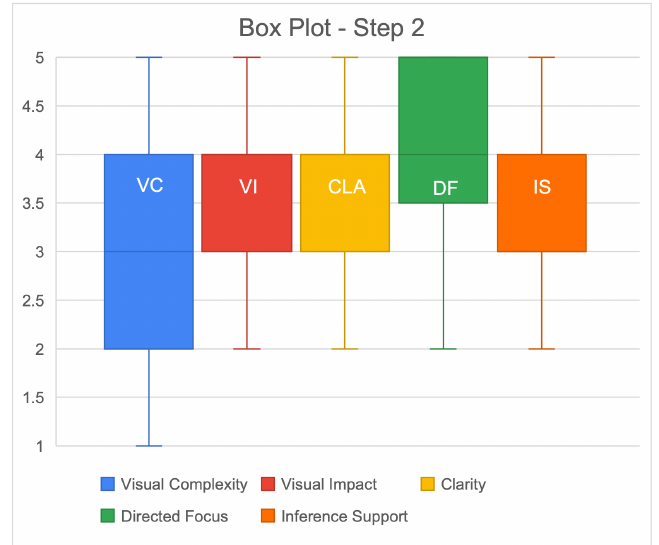
Figure 6. Boxplot chart for the results associated with the visual characteristics of Step 2 instructions— remove the screws that hold the fan.